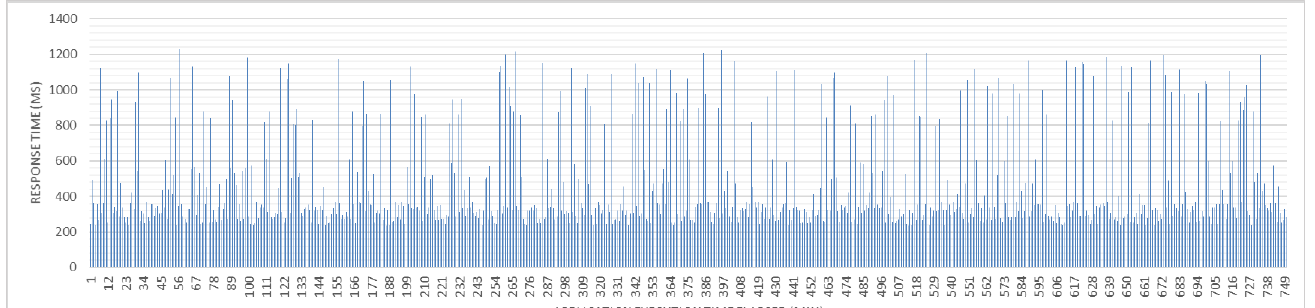
Figure 13. Response time over a period of 12.5 h when microservices were deployed using the design-pattern distribution.